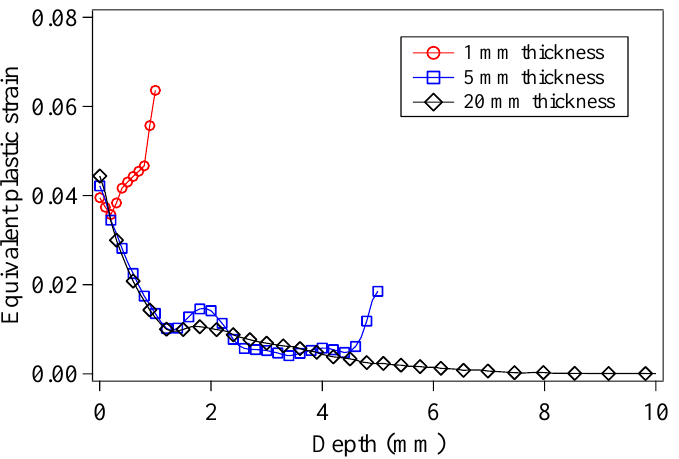
than that of the LSPed surface.